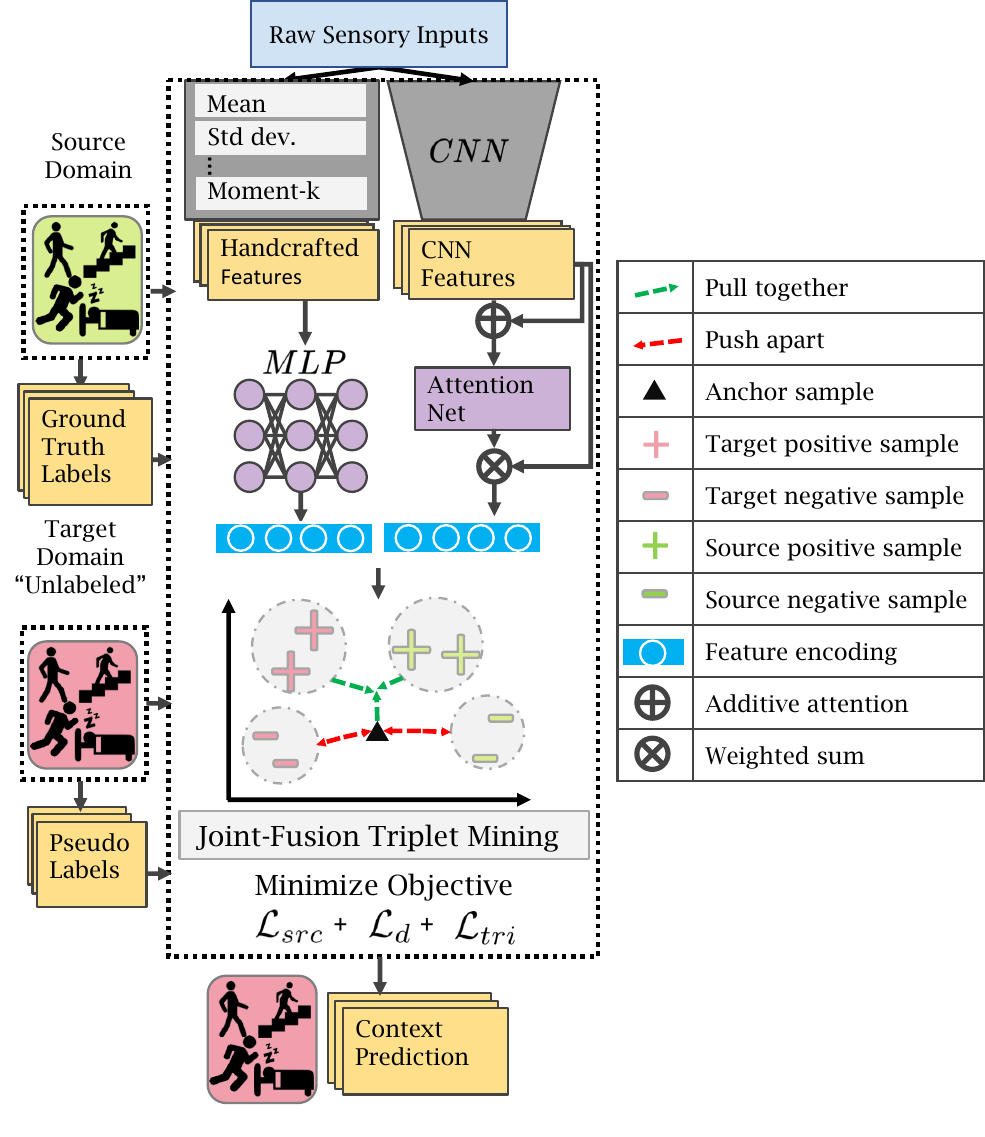
Figure 3. Triple-DARE